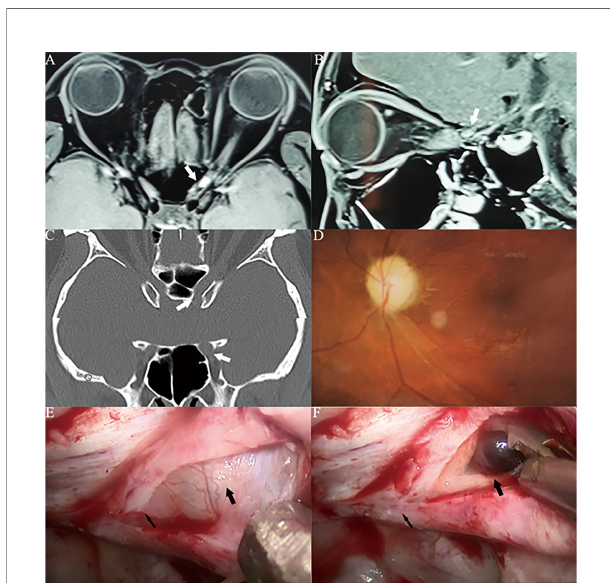
FIGURE 5 | Case3. A 30-year-old male presented with his left eye vision loss for 4 months and sudden loss of left eye vision for 3 weeks. He was misdiagnosed as optic atrophy in the local hospital and was given hormone therapy. (A, B) Optic nerve MRI showed that the left optic nerve sheath occupies, uniformly enhanced, the tumor diameter is less than 1cm (white thick arrow). The optic nerve was squeezed to the lateral side by the tumor and disappeared. (C) CT of the optic canal shows that the left optic canal is wider than the right (white thick arrow). (D) Fundus photography shows atrophy of the right optic disc. (E) The left optic canal (black thin arrow) can be seen under the vision of nasal endoscopic surgery, and the space occupying under the optic nerve sheath near the orbital foramen is blue stained. (F) Incision of the optic nerve sheath reveals that a cavernous hemangioma is located under the optic nerve sheath (black thick arrow), behind which is the cranial foramen of the optic canal (black thin arrow), cavernous hemangioma is dark red, and a history of subacute bleeding is considered.